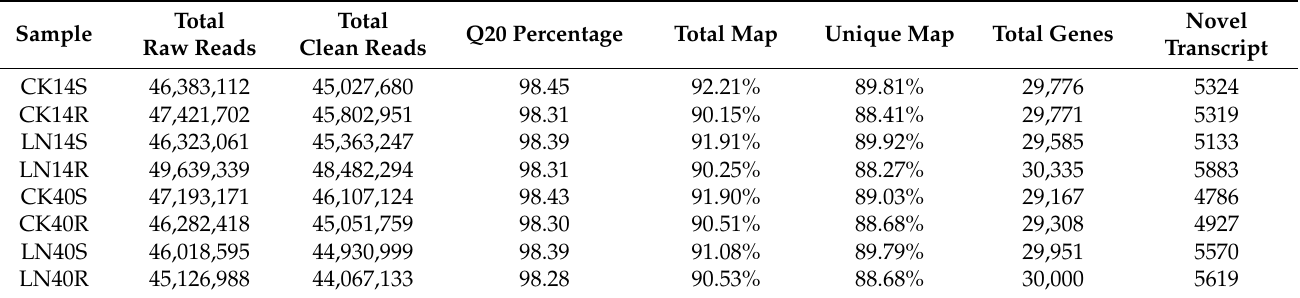
Table 2. Statistics of categorization and abundance of tags generated from the eight cDNA libraries for DEG